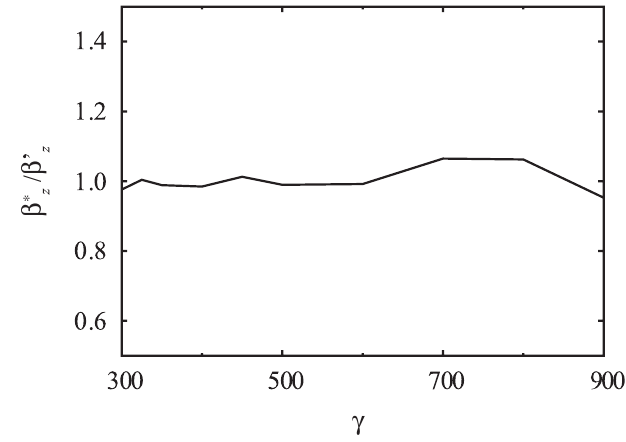
FIG. 5. The ratio of (cid:10) (cid:9) z , derived using Eq. (15) with parameters taken from the numerical calculations in both lab and rest frame runs, and (cid:10) 0 z from the numerical calculation in the rest frame. The parameters were chosen for the longitudinal bunch expan- sion regime, for which Eq. (15) must be